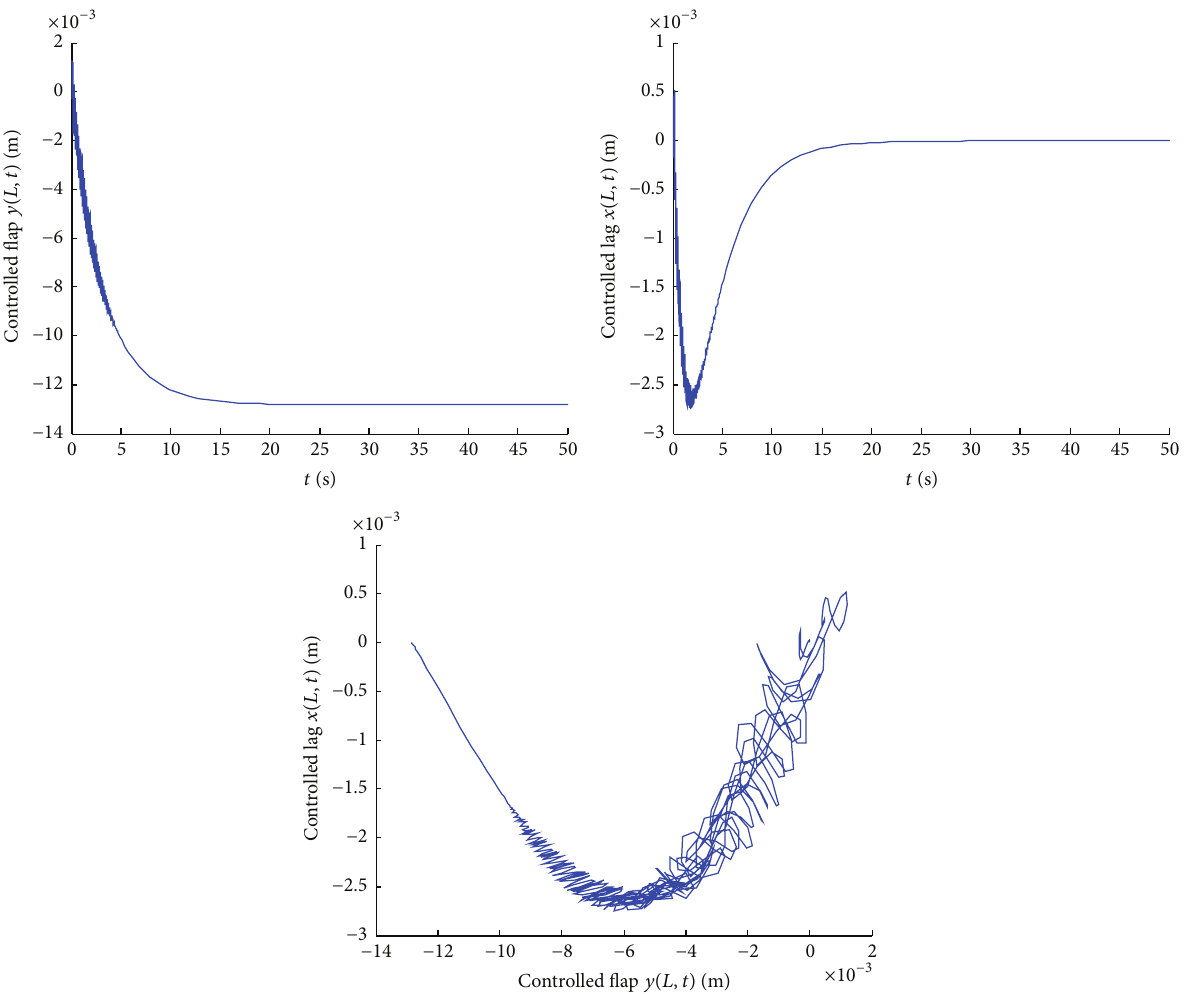
Figure 9: Controlled responses and phase plane of flap/lag motions under extreme wind condition of 𝑈 = 65 m/s with zero initial